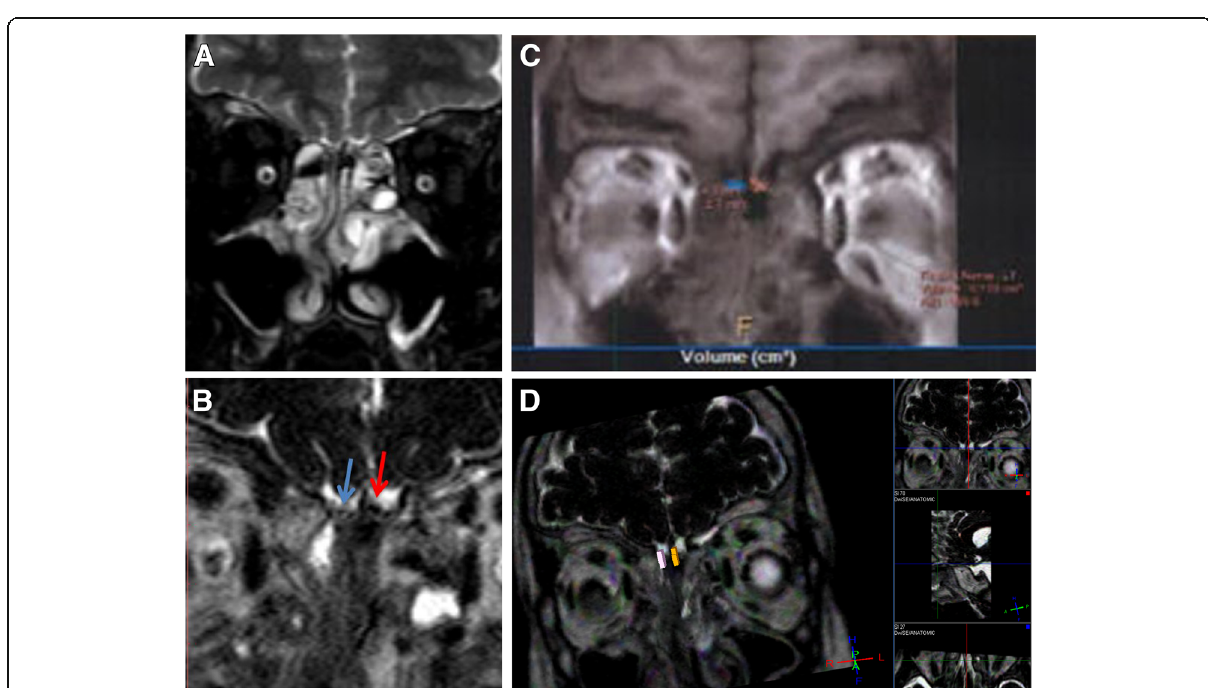
Fig. 1 Bilateral sinonasal polyposis with hyposmia. a Coronal T2 fat suppression sequence displaying bilateral ethmoidal polyposis and frontal sinus secretion obstruction. b 3D DRIVE sequence demonstrates smaller right OB (blue arrow) as compared to normal appearing left OB (red arrow) confirmed by ( c ) 3D T1WI volumetry; ROI was inserted on right bulb (blue) and left bulb (red). d Tractography for OT. The right tract has lower FA and higher ADC as compared to the normal left